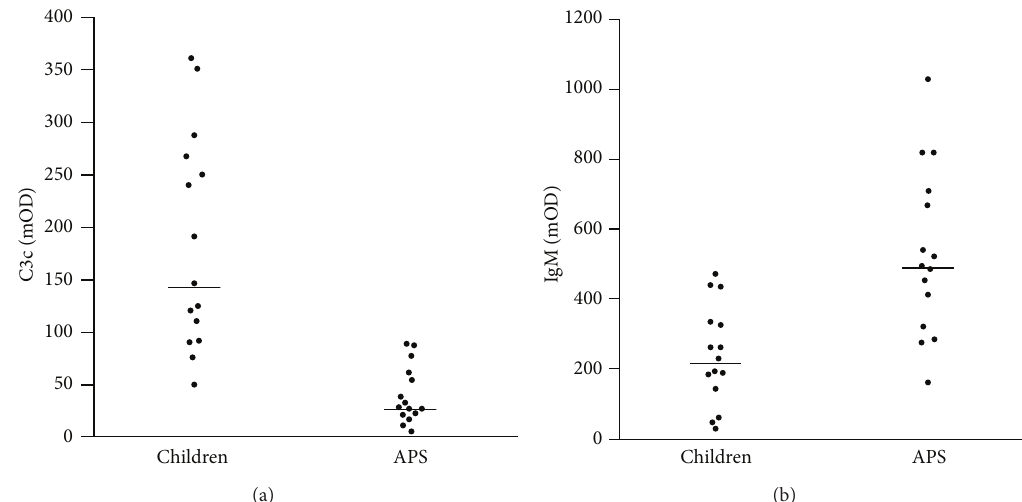
Figure 3: OD values of C3c (a) bound to anti- 𝛽 2GP1 and OD values of anti- 𝛽 2GP1-IgM (b) in sera of patients with APS and healthy children. Anti- 𝛽 2GP1 of healthy children displayed significantly more bound C3c than that of patients with APS ( 𝑝 = 0.00007 ). This suggests a more efficient clearance of 𝛽 2GP1-immune complexes in the healthy children. Anti- 𝛽 2GP1-IgM OD values of patients with APS were significantly higher than those of healthy children. Horizontal lines represent the median OD value of the cohort. APS = antiphospholipid syndrome; OD = optical density.